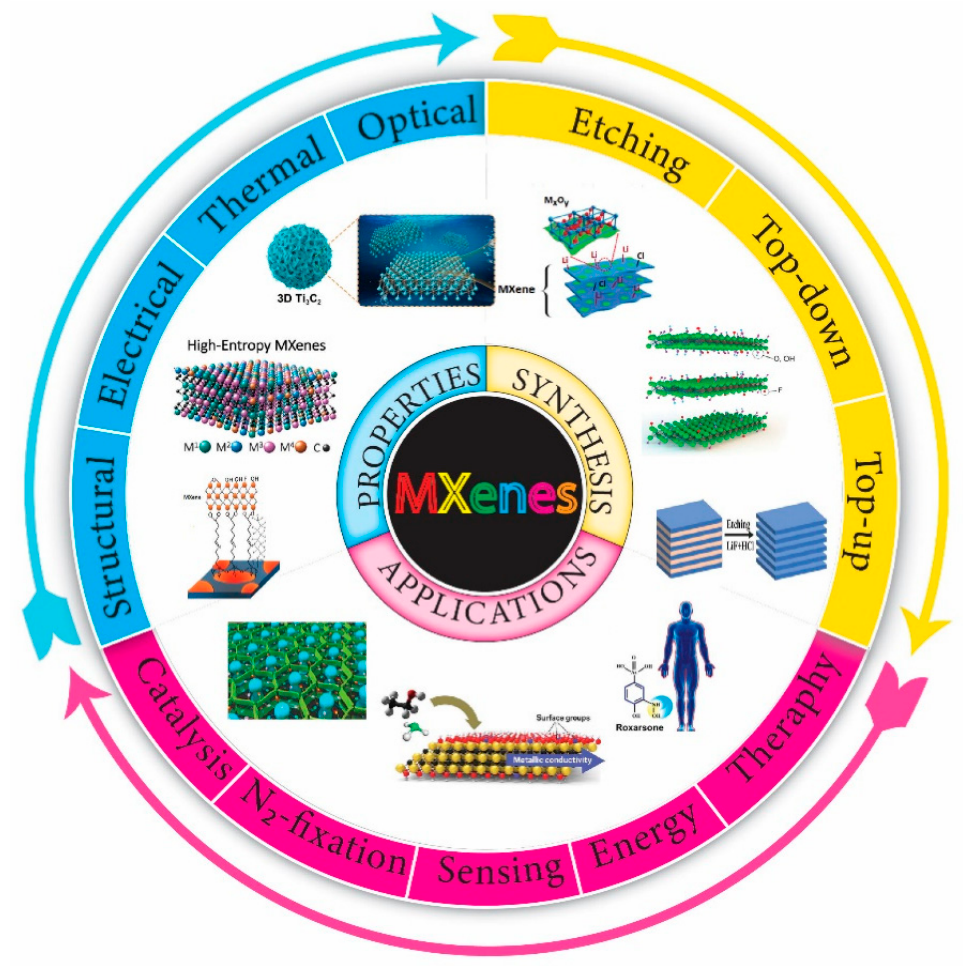
Figure 4. Diagram showing the synthesis, characteristics, and uses of MXenes. Reprinted with permission from Ref. [50].